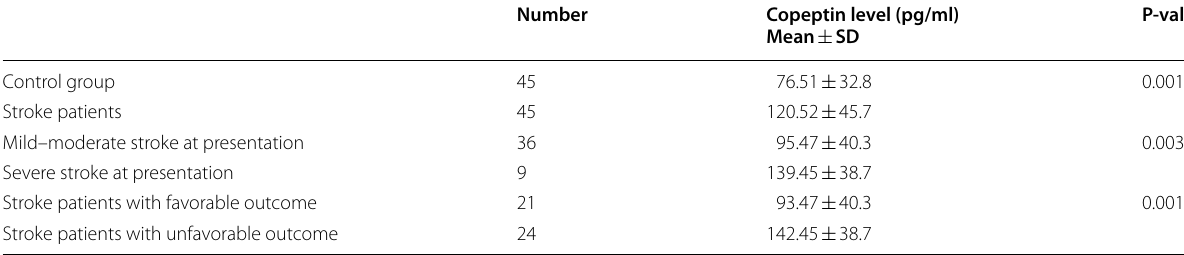
Table 3 Copeptin level in different clinical situations